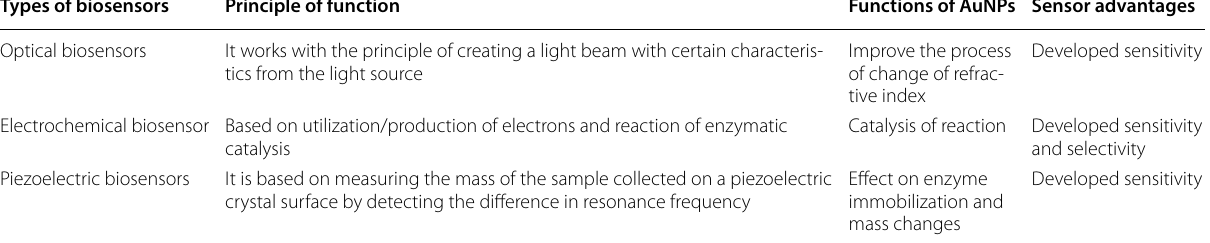
Table 1 Different functions of AuNPs in biosensors Types of